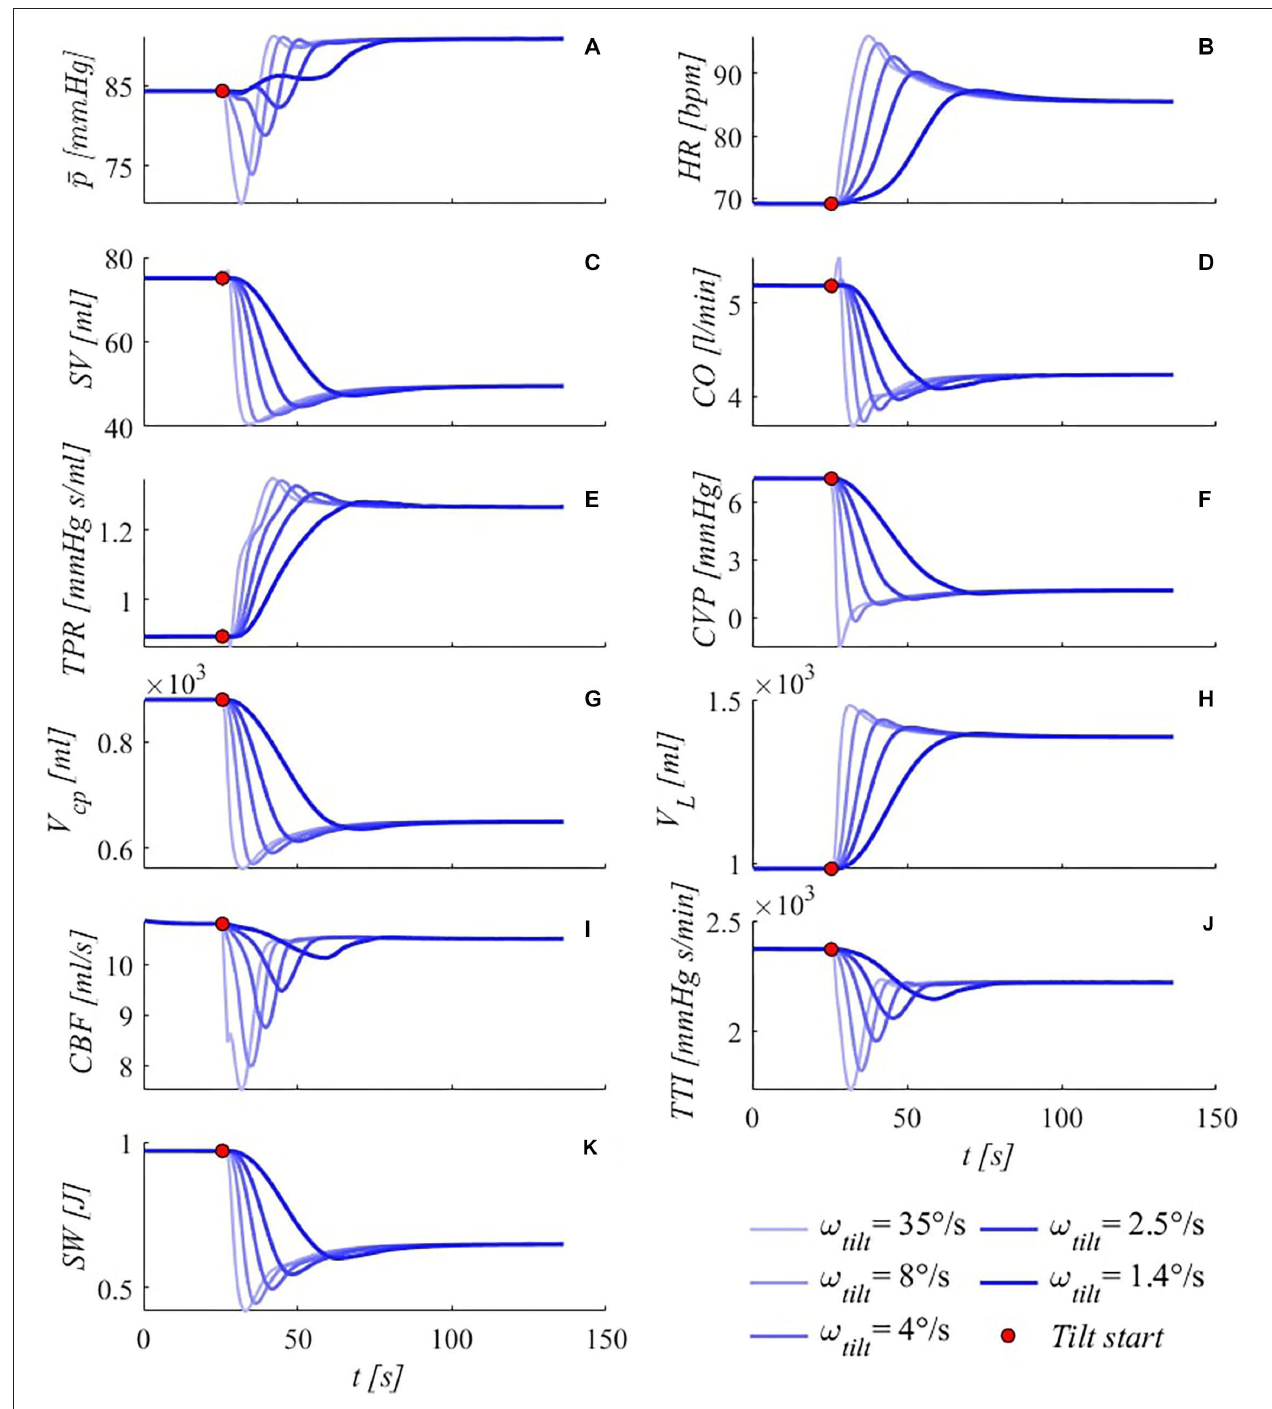
FIGURE 8 | Simulated transient response of some meaningful hemodynamic parameters to passive HUT from supine position to 70 ◦ , for five different tilting rates (35, 8, 4, 2.5, and 1.4 ◦ /s from light thin to dark thick blue lines). (A) brachial mean arterial pressure ¯ p , (B) heart rate HR , (C) stroke volume SV , (D) cardiac output CO , (E) total peripheral resistance TPR , (F) central venous pressure CVP (corresponding to right atrial pressure), (G) cardio-pulmonary blood volume V cp (blood volume of the four cardiac chambers, arterial and venous pulmonary circulation), (H) legs vascular volume V L (mostly venous blood volume, but also arterial, arteriolar, venular and capillary), (I) cerebral blood flow CBF (overall average blood flow delivered by carotid and vertebral arteries to the brain), (J) tension-time index TTI (product of the mean left ventricle pressure and RR beat duration per minute, TTI is an index of oxygen consumption), (K) stroke work SW (area of the left ventricle pressure-volume loop). Red points denote tilting starting